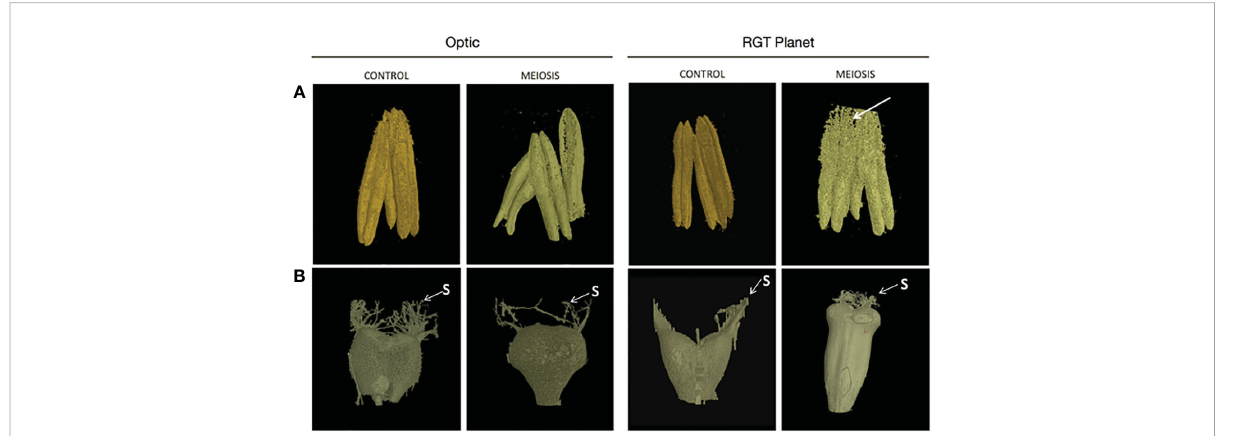
FIGURE 2 X-ray CT images of (A) anther and (B) carpel development from a representative fl oret from control and heat stress conditions for barley cultivars Optic and Planet. X-ray images of the anthers and carpels obtained by X-ray CT were compared for control environment and heat stress environment (heat stress during meiosis of pollen development) immediately before anthesis. Arrow indicates the broken septum in RGT Planet heat stressed